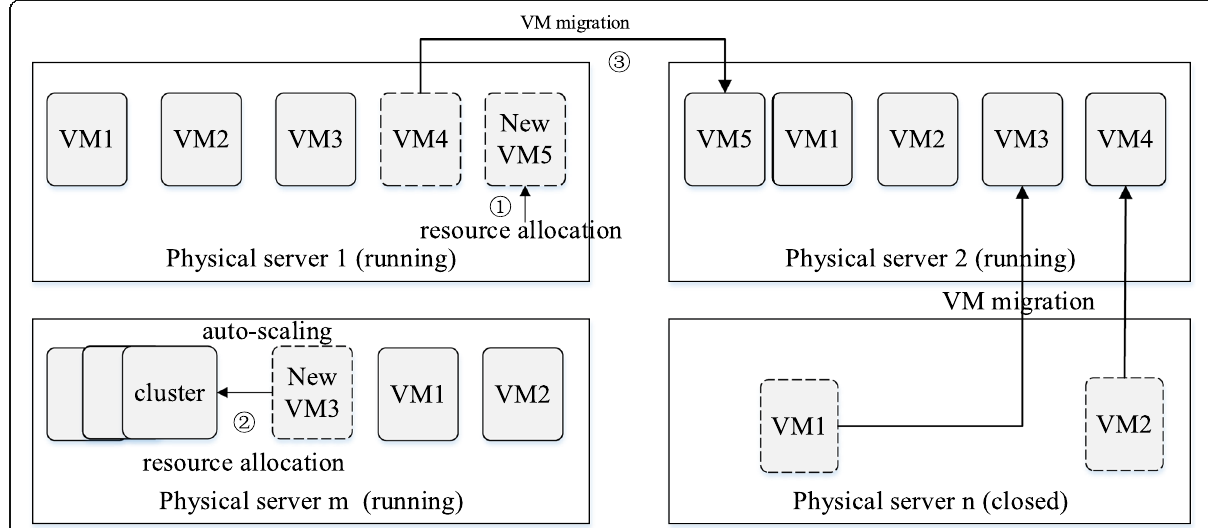
Fig. 1 Resource allocation and scheduling process of a cloud platform